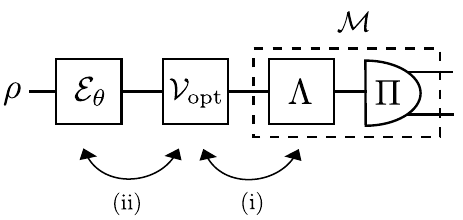
Fig. 3 | Conjugate-map decomposition of an imperfect measurement. The scheme of Fig. 1(a) with the imperfect measurement M decomposed according